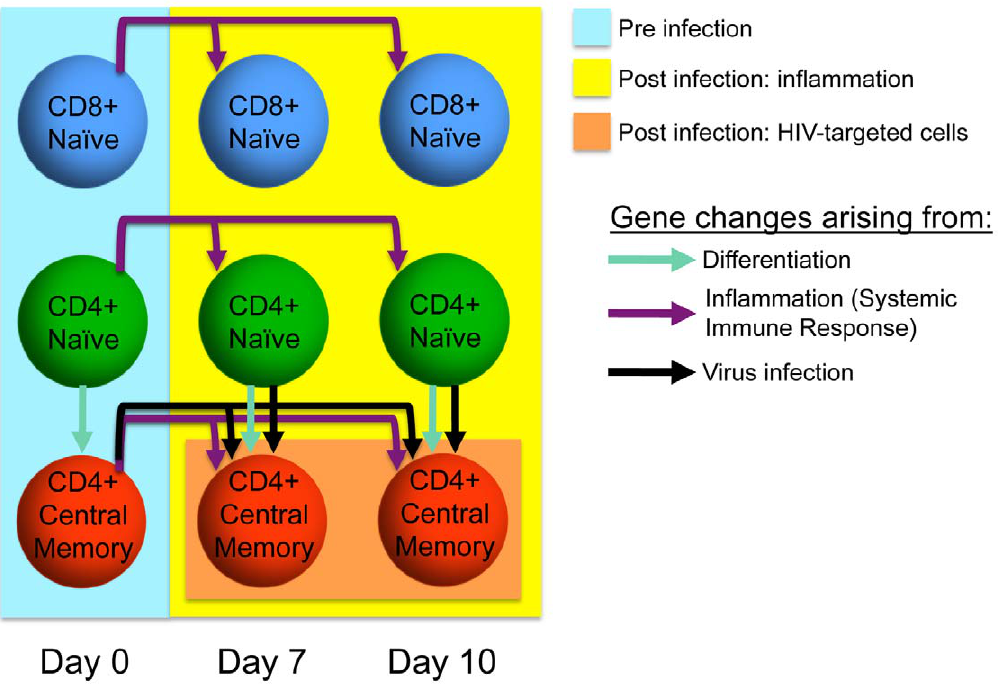
Figure 3. Schematic figure illustrating factors affecting the transcriptional changes in the three different sorted T cell subsets over the course of the infection.